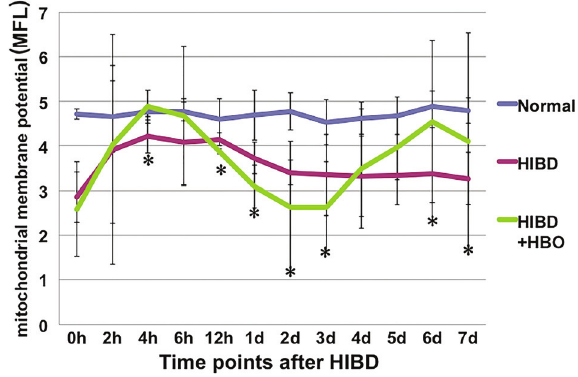
Figure 1. Change in mitochondrial membrane potential ( Dc m) in ispilateral cortex of newborn rats after hypoxic-ischemic brain damage (HIBD) and HIBD with daily hyperbaric oxygenation (HBO) treatment for 7 days. The change in DC m (mean fl uorescence level, MFL) in both groups showed fl uctuating pattern. Within 2 to 12 h after HI insult, DC m of the HIBD group recovered to some extent, but in the HIBD + HBO group it recovered to almost normal levels. A secondary drop (more severe in the HIBD + HBO group) was observed in both groups at 1 – 4 days after hypoxia-ischemia (HI) insult. A secondary recovery was observed in the HIBD + HBO group only. Data are reported as means ± SD. *P o 0.05, signi fi cant differences between HIBD and HIBD + HBO groups (ANOVA followed by Tukey ’ s post hoc